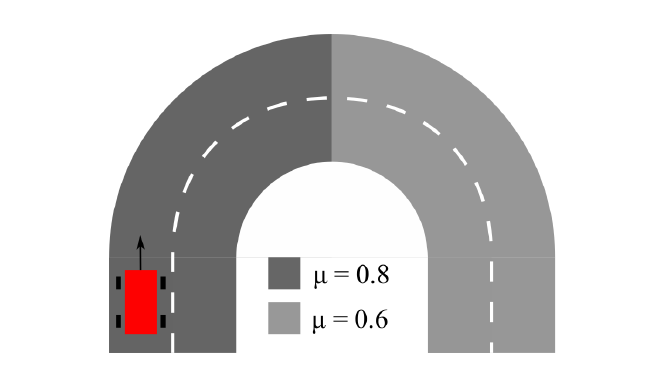
Figure 14. U-turn, µ jump: road definition.